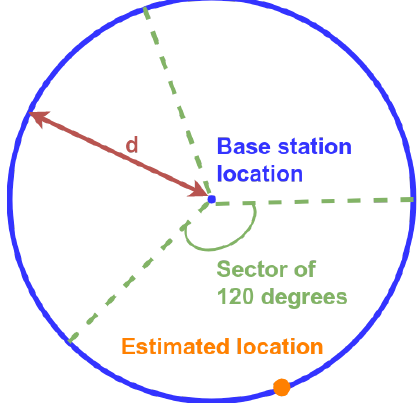
Figure 4. Visualization of the RSS-based ranging algorithm with sector information. A single receiving NB-IoT base station antenna covers a sector of 120 degrees. The RSS from that antenna is translated into a distance d . The location of the UE is estimated to be at the center of the resulting